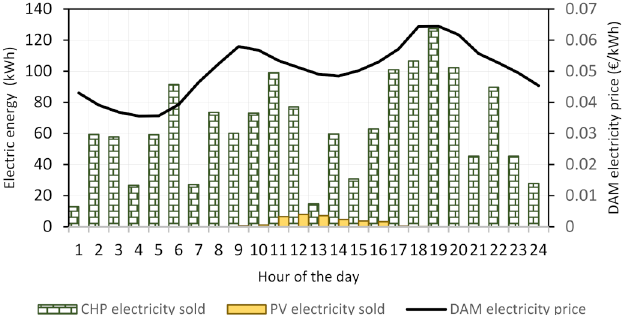
Figure 18. Bidding strategies of the ILEC on DAM obtained with stochastic economic optimization for the representative winter day.